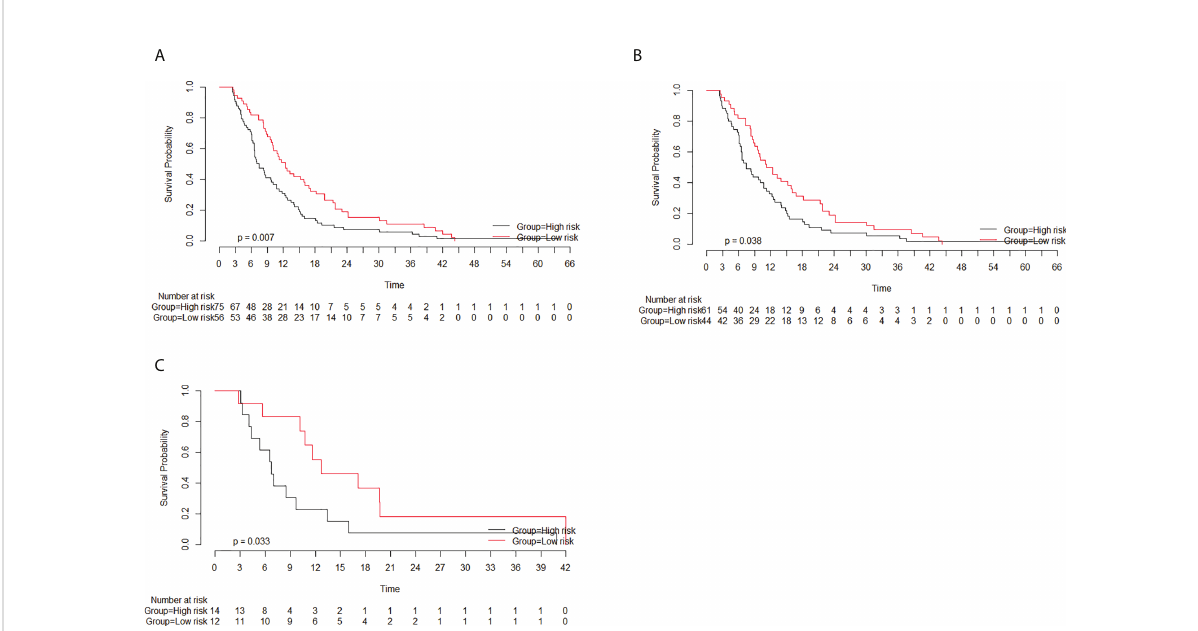
FIGURE 4 Survival curves of the high- and low-risk groups based on the radiomics score (rad-score) classi fi cation. The rad-scores in the high- and low- risk groups were more than − 0.6 and less than − 0.6, respectively. (A) Considering all patients, the median overall survival (OS) rates in the high- and low-risk groups were 7.4 months (95% CI, 6.5 – 10.7) and 12.4 months (95% CI, 10.0 – 16.8), respectively ( p = 0.007). (B) Considering the training cohort, the median OS rates in the high- and low-risk groups were 7.5 months (95% CI, 6.5 – 11.2) and 11.8 months (95% CI, 9.6 – 16.8), respectively ( p = 0.038). (C) Considering the validation cohort, the median OS rates in the high- and low-risk groups were 6.8 months (95% CI, 4.3 – NA) and 12.6 months (95% CI, 10.7 – NA), respectively ( p = 0.033).